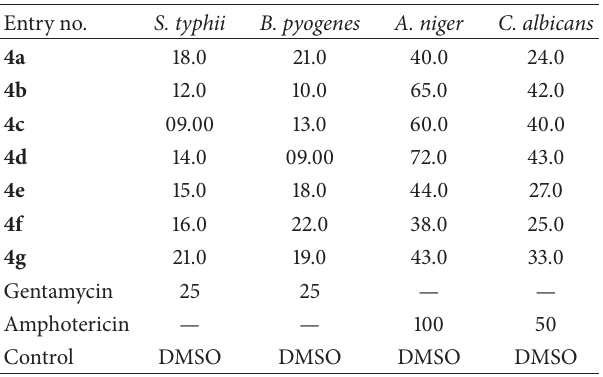
Table 4: Antimicrobial activities of the compounds (MIC, mg/mL) 4a – g . Entry